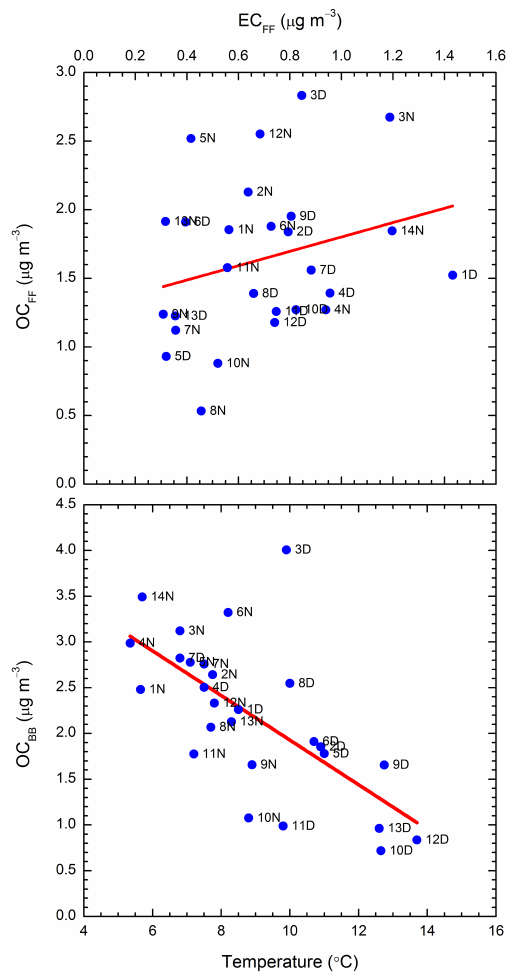
Figure 8. Scatter plots between atmospheric concentrations of NO x and apportioned EC FF , and of arabitol and apportioned OC BIO for the PM 2 . 5 size fraction in central Budapest. The red lines represent a linear fit to the data. The data points 1D and 1N on the lower panel were excluded from the data set when fitting. The order number of the samples together with daylight time (D) or night (N) periods is indicated by labels next to the data